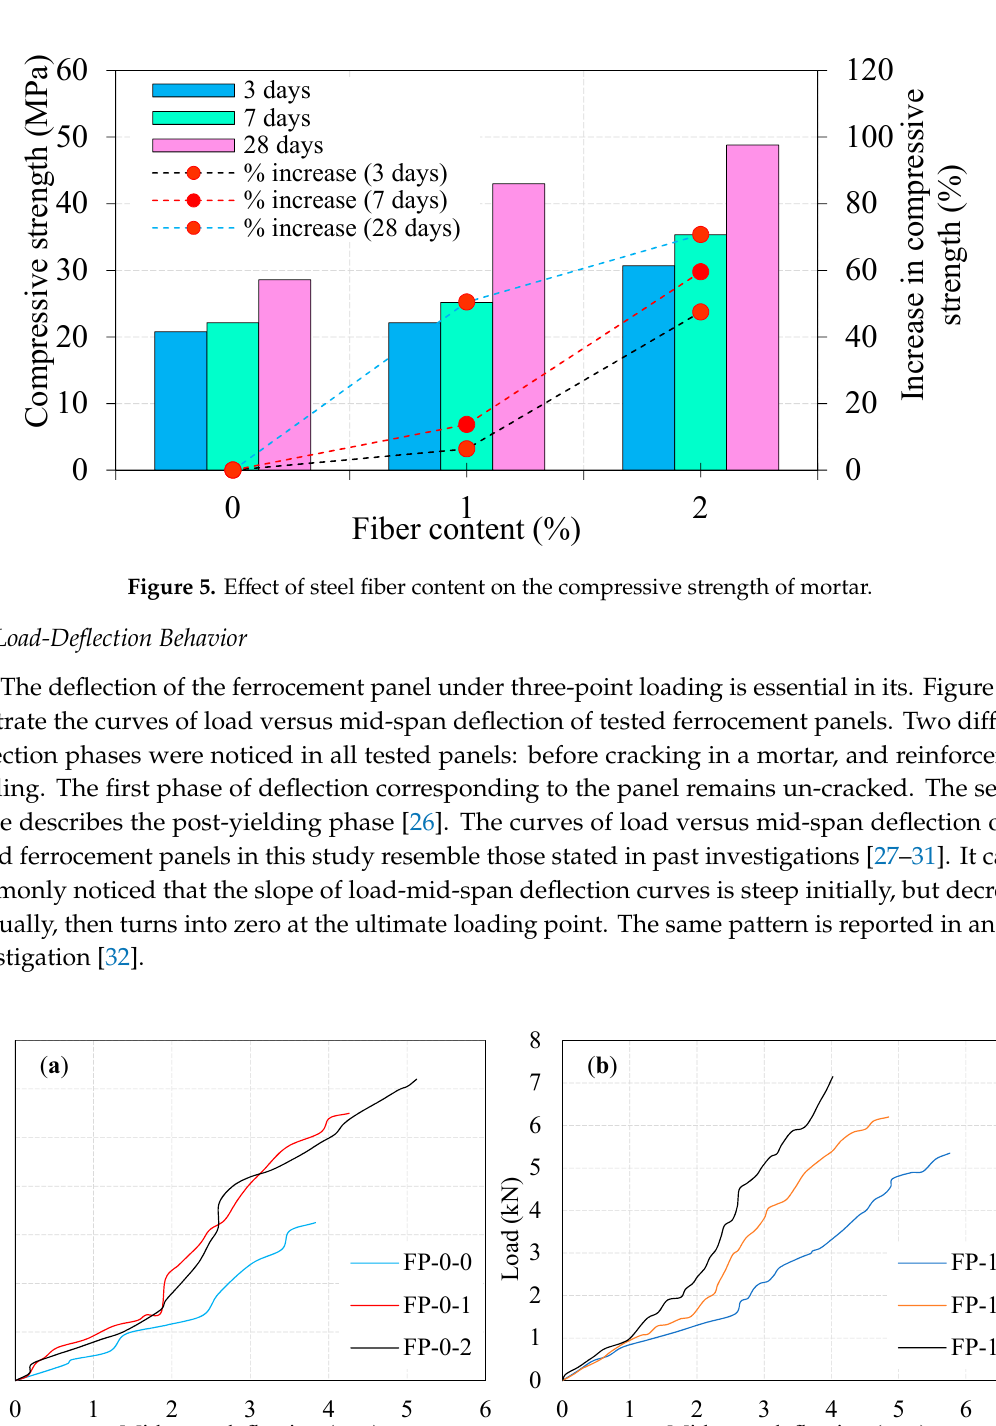
( b ) Figure 4. Test setup ( a ) flexure and ( b ) impact. 4. Discussion of Results 4.1. Compressive Strength Fiber characteristics affect the development of the compressive strength of cement mortar over time. It can be seen that the compressive strength of steel fiber used to cement mortar was enhanced in the early days at a higher dosage of fiber. The effect of the steel fiber dosage on the compressive strength of mortar cube specimens is shown in Figure 5. It shows that the addition of fibers increased the compressive strength than the non-fibrous specimen. The addition of 1% and 2% dosage of fiber leads to an increase in compressive strength by about 6.4% and 47.5% at 3 days, respectively, compared to non-fibrous specimens. Further increase in compressive strength was observed by about 13.7% and 59.5% at 7 days and 50.5% and 70.8% at 28 days. With fibers, the instigation of cracks due to tensile stress and possible shear stress appear to be delayed and also appear postponed. This phenomenon is because when a crack meets a fiber, it requires more energy of fracture to drag the fiber out and then extend. Therefore, the relative limit and ultimate strength of the mortar cubes are generally augmented; this is intensely reliant on the fibers’ matrix, stiffness, and dispersion. So that if the interfacial bond is adequate, the surrounded matrix between the fibers will be restricted, and subsequently, a higher strength capacity is attained. Findings indicated that the increase in compressive strength is influenced by the content of fiber in the specimens. In the nutshell, the addition of steel fibers also contributed to the strength enhancement of the test specimens. This is due